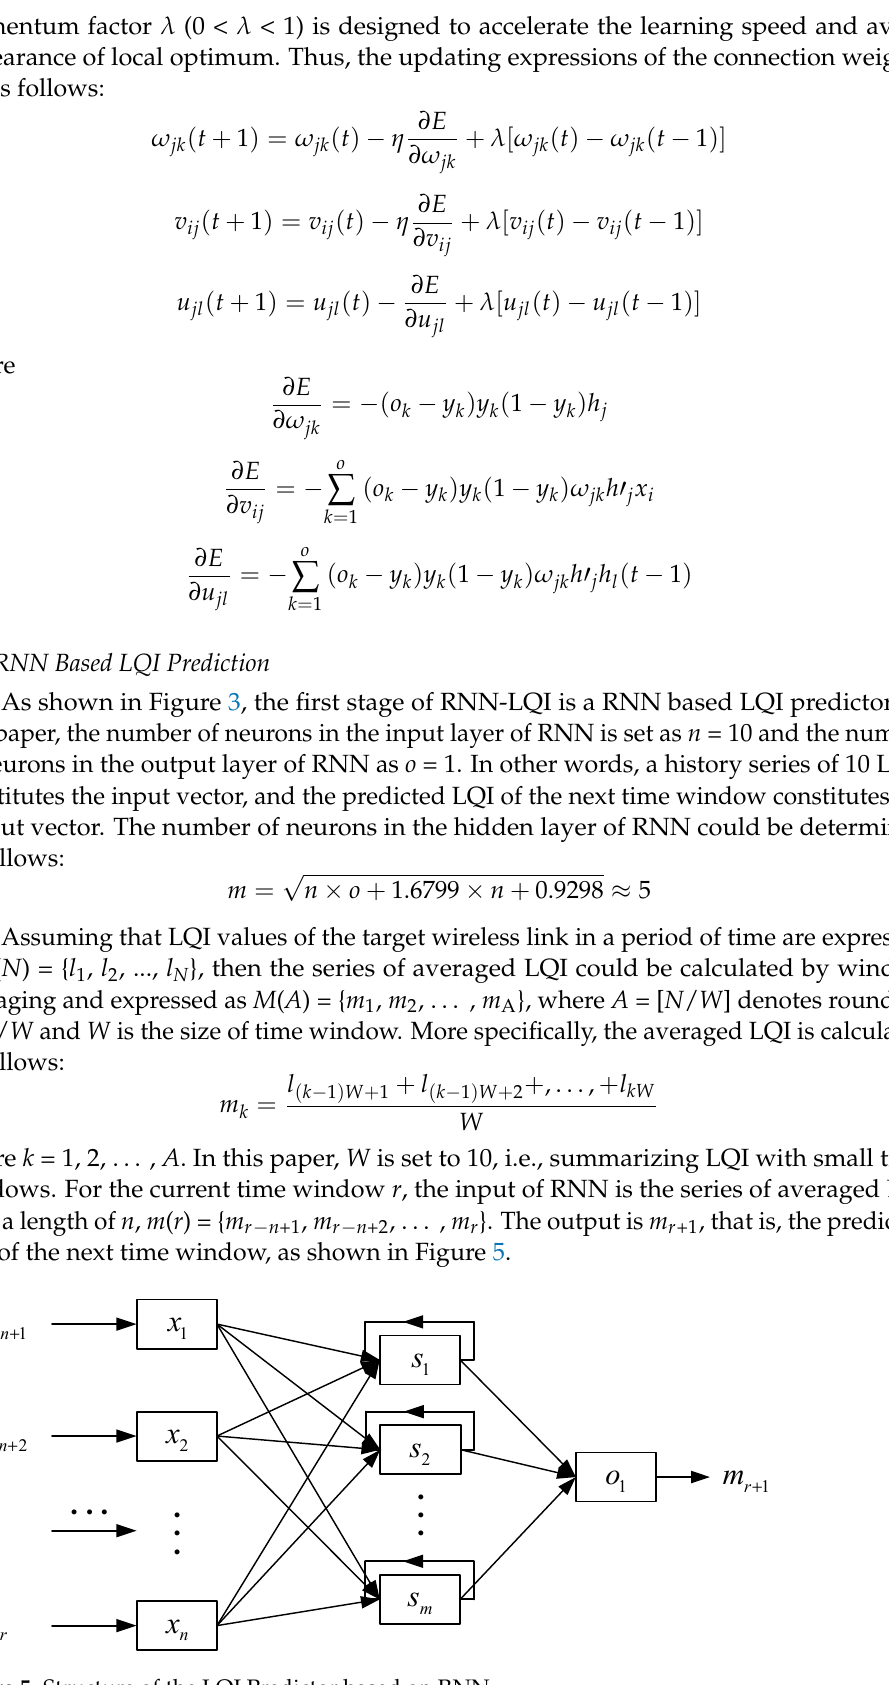
Figure 5. Structure of the LQI Predictor based on RNN.